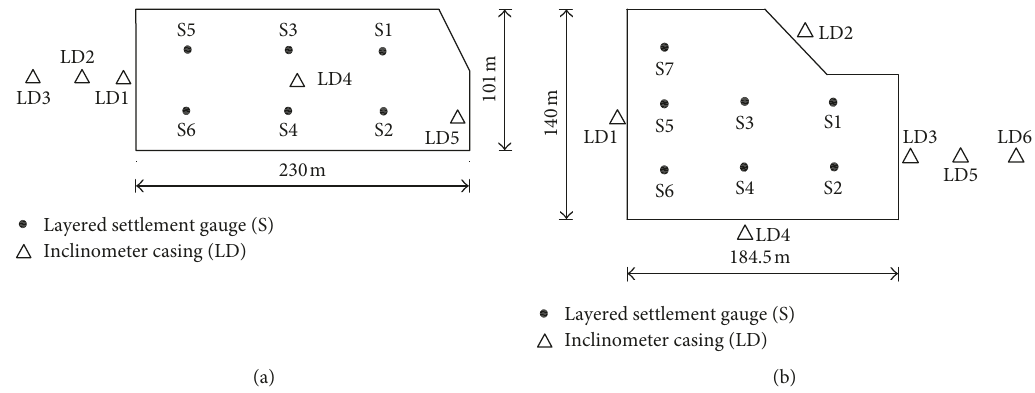
Figure 4: Plan layout of instrumentation points. (a) Section 1 and (b) Section